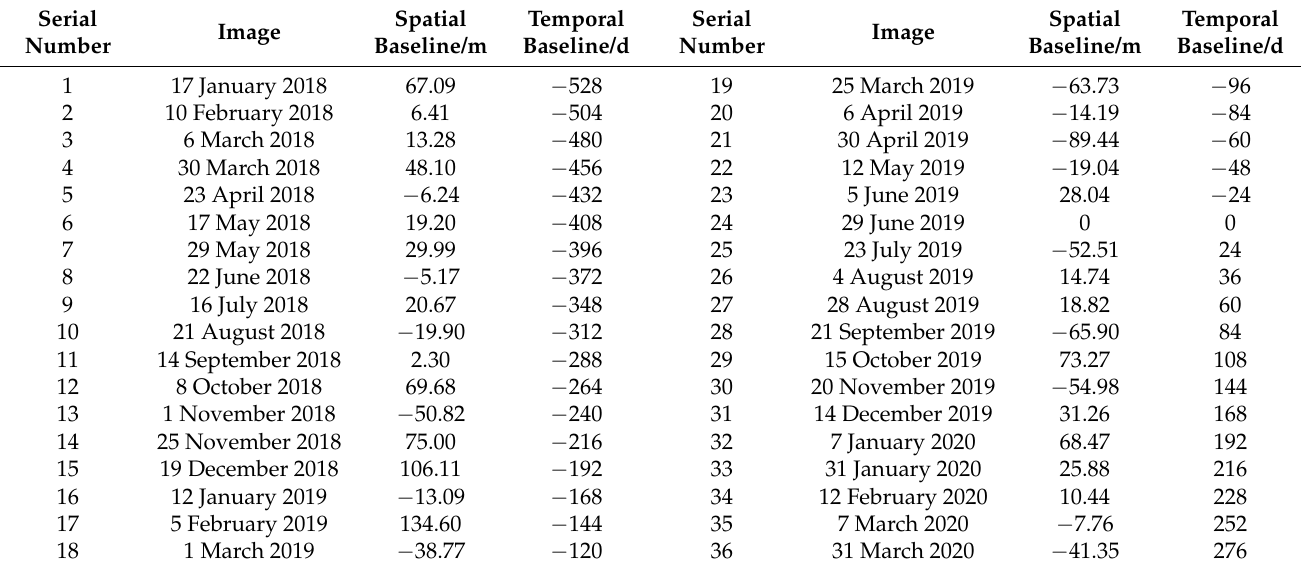
Figure 1. ( a ) Time-position of Sentinel-1A image interferometric pairs; and ( b ) time-baseline of image interferometric pairs. The red lines depict interferometric pairs. The yellow and green diamonds correspond to the reference image and secondary images, respectively. Table 1. Spatial–temporal baseline distribution parameters of Sentinel-1A.